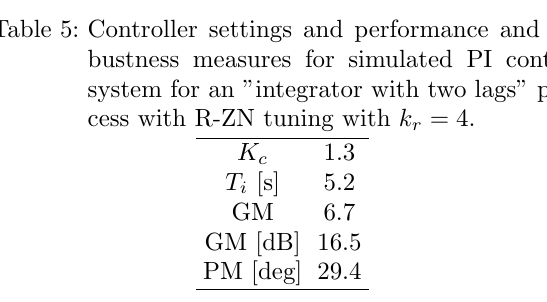
Figure 13: Responses with various PI settings.